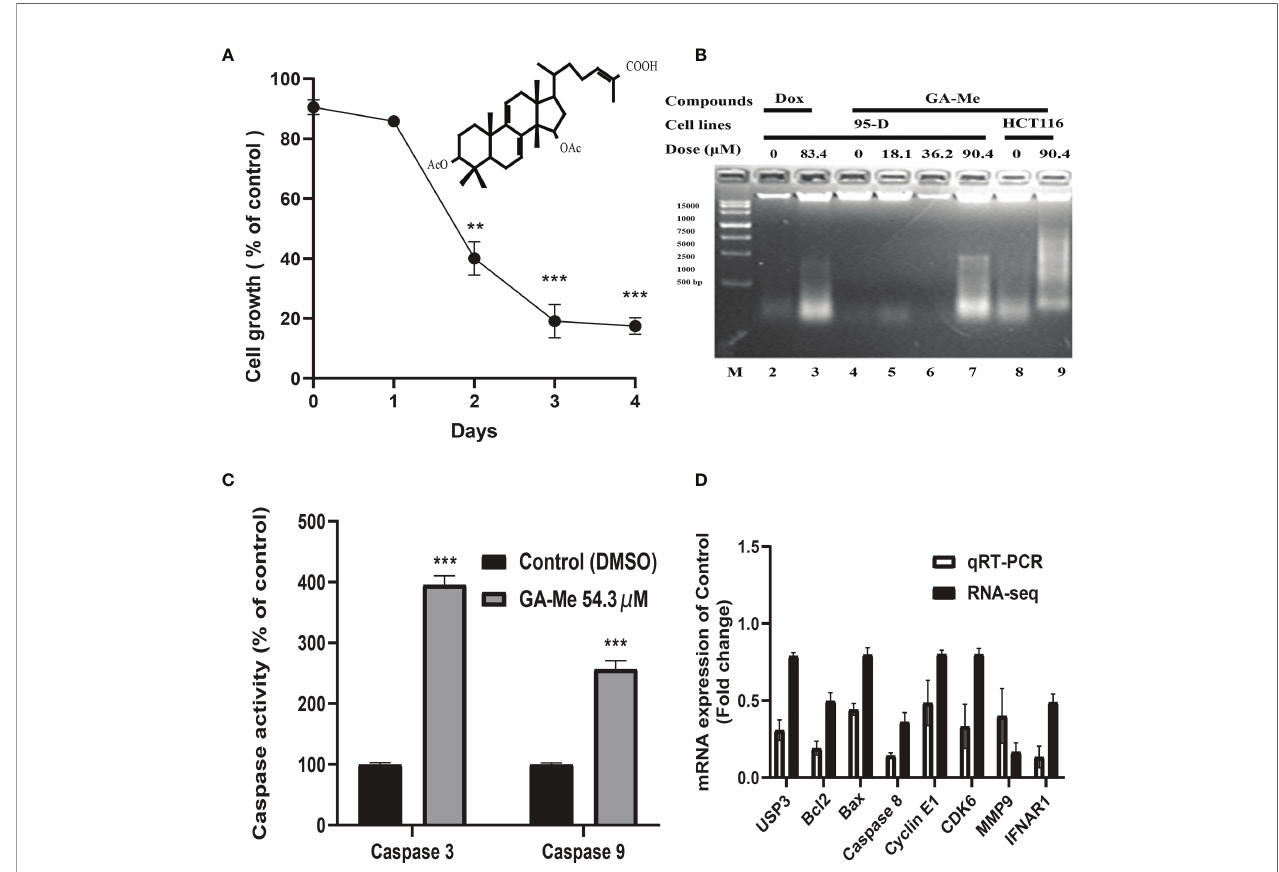
FIGURE 2 | (A) : GA-Me inhibited the proliferation of HCT116 cells. After HCT116 cells were incubated with or without 18.1 µM GA-Me, the growth-inhibitory effects of GA-Me were compared by performing trypan blue staining and cell viability assays. Statistical signi fi cance of differences between DMSO and GA-Me groups: ** p <0.01 and *** p <0.001. (B) : GA-Me induced DNA fragmentation in HCT116 and 93-D cells. The indicated concentrations of GA-Me ( Lane 7 ) and Dox ( Lane 3 , positive control) induced DNA fragmentation in 95-D cells; additionally, 90.4 µM GA-Me induced DNA fragmentation in HCT116 cells ( Lane 9 ). The DNA marker is shown as Lane M . (C) : GA-Me signi fi cantly activates caspase-9 and caspase-3 in HCT116 cells. HCT116 cells were treated with or without 54.3 m M GA-Me for 24 hours. Caspase-3/7 and caspase-9 activity was measured using a Caspase-Glo-3/7 or Caspase-Glo-9 assay kit as described in “ Materials and Methods ” . Data are presented as the means ± SD. Statistical signi fi cance was determined using Student ’ s t test , where *** indicates p < 0.001 compared with 54.3 µM GA-Me. (D) The differential expression of mRNAs was validated using qRT – PCR. The expression levels of the UPS3, BCL2, BAX, caspase-8, Cyclin E1, CDK6, MMP9 and IFNAR1 mRNAs were downregulated in GA-Me-treated HCT116 cells compared to untreated HCT116 cells. The heights of the columns in the chart represent the FC. The qRT – PCR results were consistent with the RNA-Seq data. GA-Me represents HCT116 cells treated with GA-Me. Control represents untreated HCT116